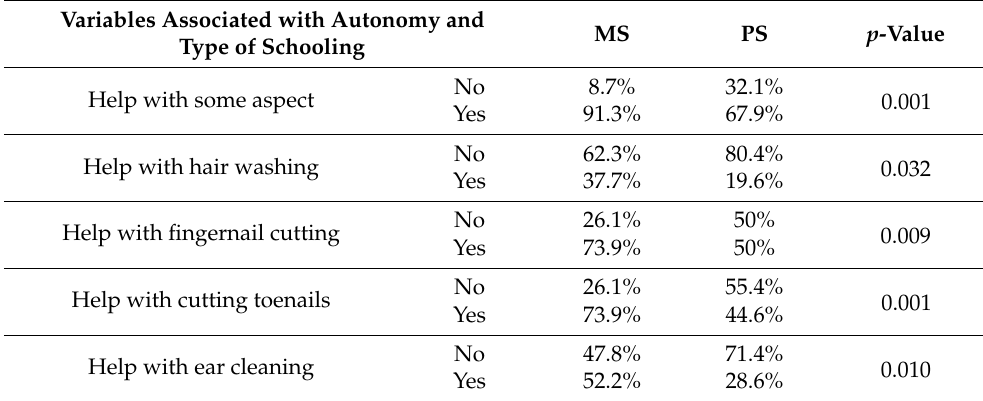
Table 2. Association between personal autonomy and type of